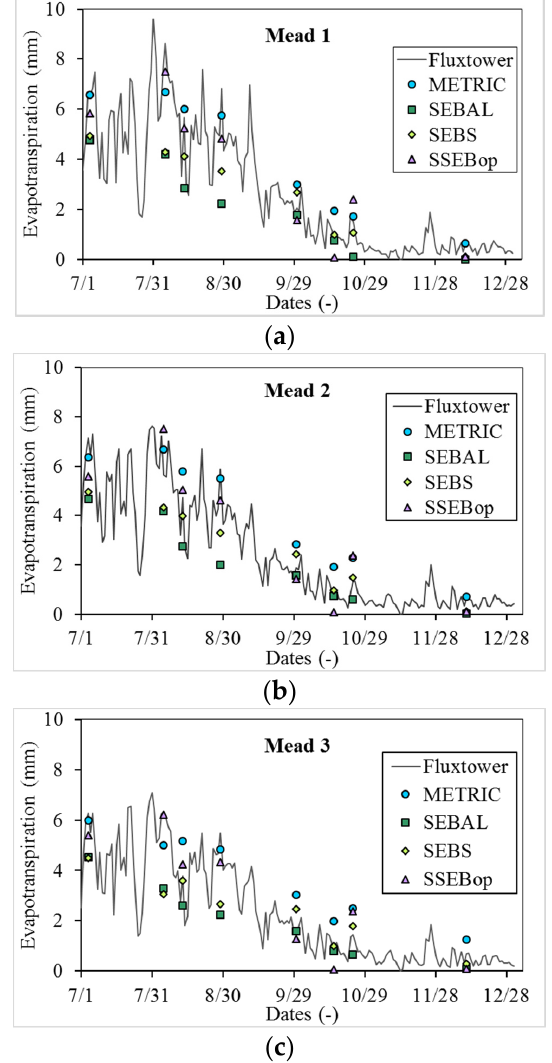
Figure 8. Temporal variation of evapotranspiration measured using eddy covariance at Mead Site 1 ( a ); Mead Site 2 ( b ); and Mead Site 3 ( c ) during 2001. ET estimated using the METRIC, SEBAL, SEBS, and SSEBop models on the days of satellite overpasses are also shown.